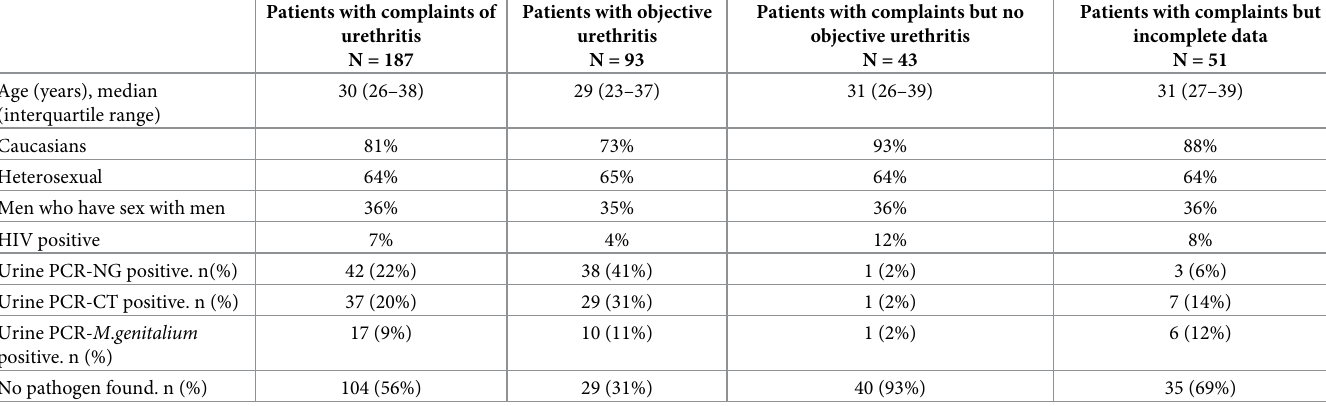
Patients with complaints of Patients with objective Patients with complaints but no urethritis urethritis objective urethritis N = 187 N = 93 N = 43